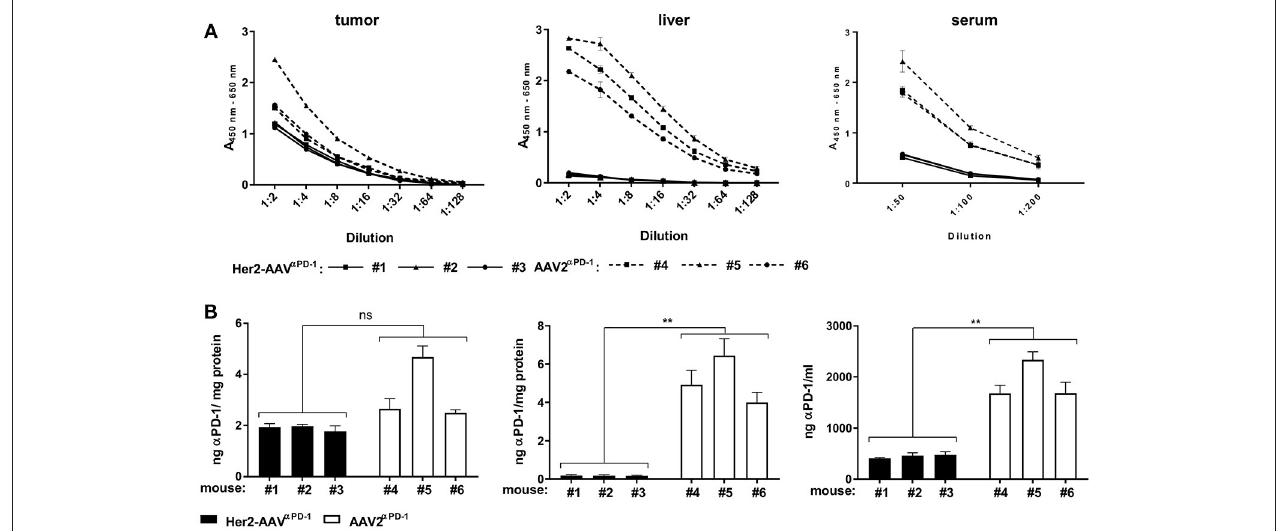
FIGURE 4 | Tumor-targeted delivery of α PD-1 by Her2-AAV. RENCA-Her2/neu bearing BALB/c mice received a single intravenous injection of 1.1 × 10 11 genome copies of AAV2 α PD − 1 ( A : dashed lines, B : white bars), Her2-AAV α PD − 1 ( A : black lines, B : black bars) or PBS as mock control. One week after vector administration organs were explanted and sera taken. AAV mediated delivery of the immune checkpoint inhibitor in tumor and liver organ lysates as wells as in sera of the mice was analyzed by sandwich ELISA using IgG-Fc- and HA-specific antibodies. (A) Raw data obtained by ELISA. Values obtained with sera or organ lysates from PBS injected animals were subtracted from the ELISA signals of mice that had received AAV vectors. ( n = 3 mice per organ and vector type are shwon; tumor: n = 1 per dilution, liver: n = 3 technical replicates per dilution, sera: n = 3–4 technical replicates per dilution; mean ± SD). (B) Amounts of α PD-1 present in tumor, liver, and serum. The amounts of α PD-1 in the organ lysates were normalized to the total protein yields. The quantity of α PD-1 in sera was calculated as ng/ml. (tumor: n = 3 technical replicates per mouse, liver: n = 9 technical replicates per mouse; serum: n = 5–7 technical replicates per mouse; mean ± SD). ** p < 0.01; ns, not significant by unpaired t -test ( n = 3 mice per organ and vector type, numbers mean individual